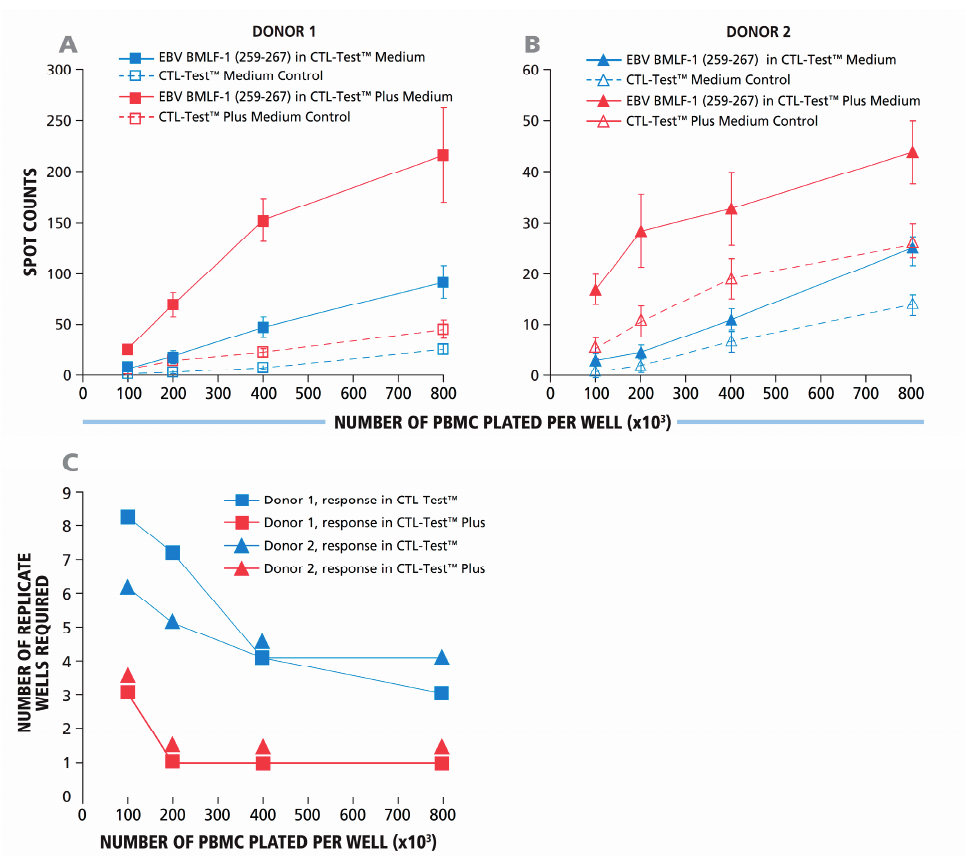
Figure 5. Using more cells per well reduced the number of replicate wells required to detect weak subdominant responses. Using IL-7 containing signal-enhancing CTL-Test Plus™ medium further increased the signal-to-background ratio to the point where even a single well suffices to reveal a positive response, even at low cell numbers.